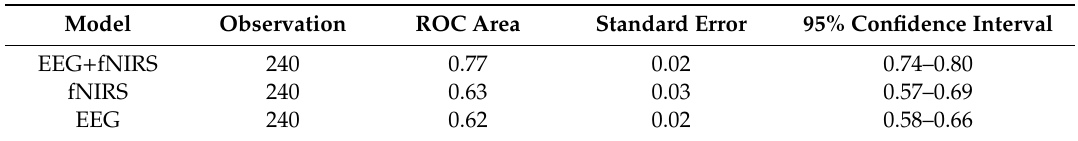
Figure 11. Comparison of the proposed method (EEG + fNIRS) and the ones where only EEG or fNIRS employed for all video-content trials.